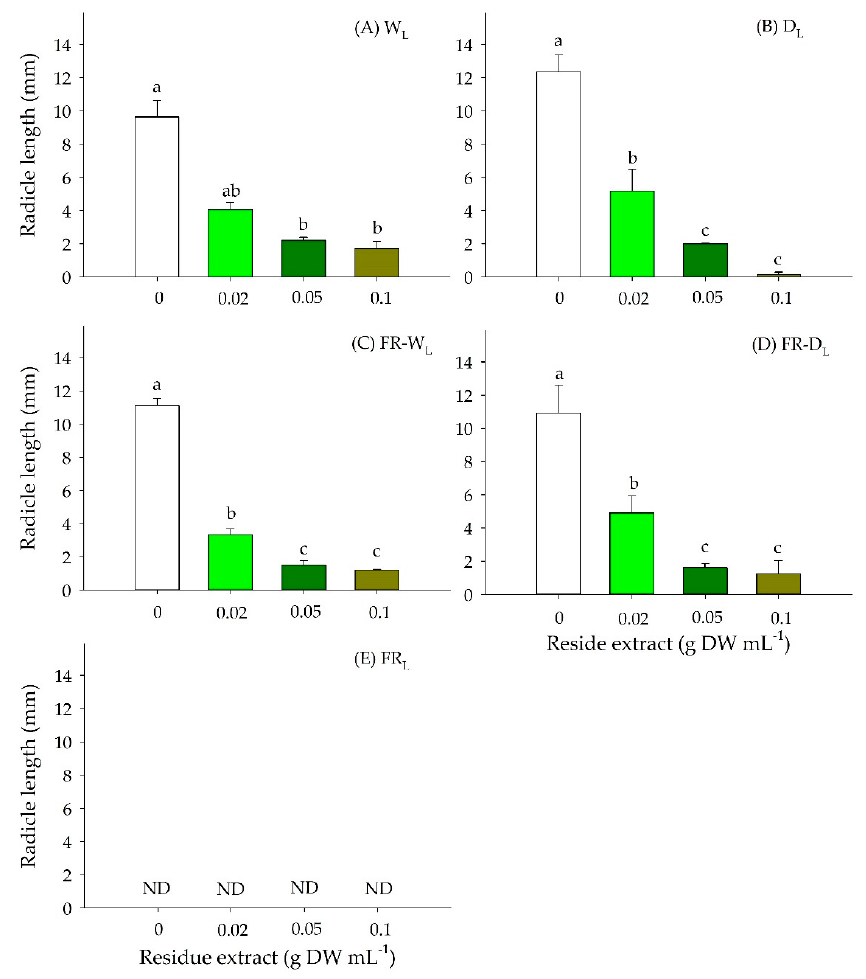
Figure 4. Radicle growth of Cobbler’s pegs treated with four concentrations of residue extract (0, 0.02, 0.05 or 0.1 g DW mL − 1 ) and five light treatments: ( A ) incubated in white light with a 12-h photoperiod (W L ); ( B ) incubated in the continuous darkness by wrapped with two layers of aluminum foil (D L ); ( C ) pretreated in the FR for 3 h then incubated in the white light with a 12-h photoperiod (FR-W L ); ( D ) pretreated in the FR for 3 h then incubated in the continuous darkness (FR-D L ); ( E ) incubated in FR with a 12-h photoperiod (FR L ). The light intensities of white light (LED, 400–750 nm, 6500 k) and FR (LED, 730 nm) were 149 µmol m-2 s − 1 and 0.71 µmol m − 2 s − 1 , respectively. The R/FR ratios of white and far-red LED light were 11 and 0.01, respectively. The same letters in ( A ) indicate no significant difference at p < 0.05 by Dunn’s post hoc comparison test, while in ( B – D ) indicate no significant difference at p < 0.05 by Fisher’s protected LSD test. ND in ( E ) means no seed germinated in FR L treatment during the 5-day incubation.